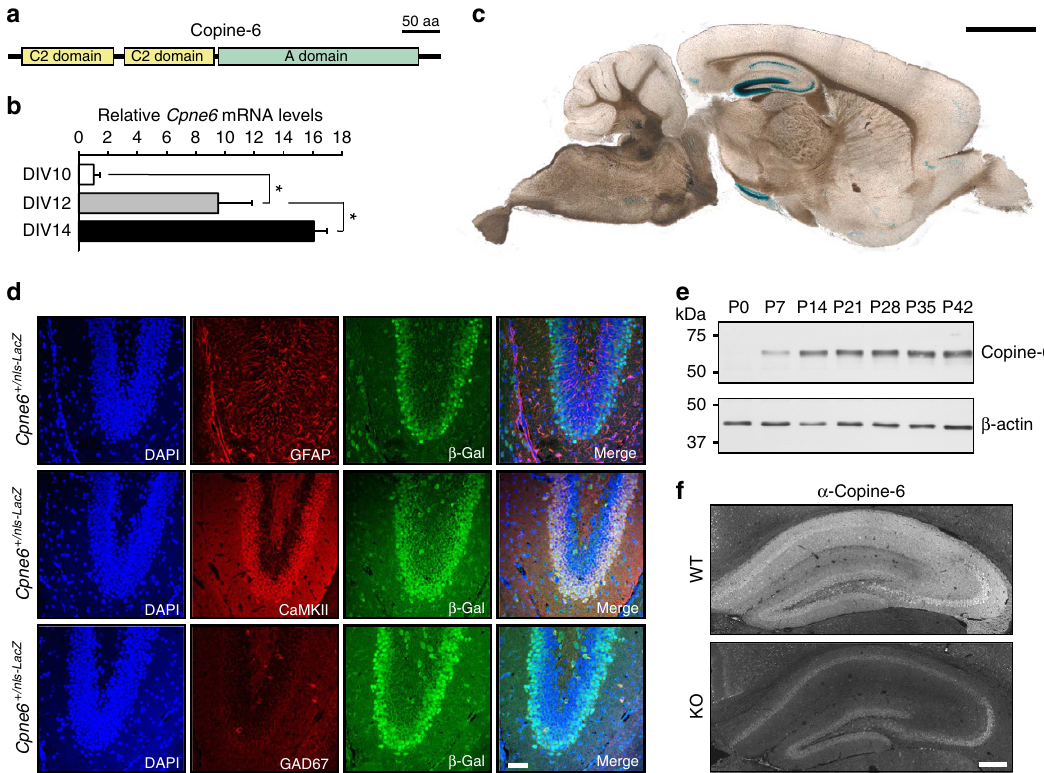
Figure 1 | Expression of Copine-6 in cultured hippocampal neurons and postnatal brain. ( a ) Schematic illustration of the domain architecture of Copine-6. ( b ) Cpne6 mRNA levels were measured in low-density primary rat hippocampal cultures by real-time PCR at DIV 10, 12 and 14. Data are mean ± s.d. from n ¼ 2 cultures per time point. * P o 0.05 by one-way ANOVA with Tukey’s post-hoc test. ( c ) Sagittal brain section of a 6-week-old Cpne6 þ /nls-LacZ mouse. Cpne6 -driven nls-LacZ expression is detected by the blue b -Gal staining in the nuclei. Scale bar, 1.5mm. ( d ) Coronal sections of the dentate gyrus from 2-week-old Cpne6 þ /nls-LacZ mice were stained with DAPI (4,6-diamidino-2-phenylindole; blue), antibodies to b -galactosidase ( b -Gal; green) and the antigens indicated. Glial fibrillary acidic protein (GFAP; astrocyte marker); calcium/calmodulin-dependent protein kinase II (CaMKII; excitatory neurons); glutamate decarboxylase 67 (GAD67; inhibitory neurons). Scale bar, 50 m m. ( e ) Western blot analysis of hippocampal lysates of mice of indicated age. b -actin was used as loading control. ( f ) Coronal sections of the hippocampus from 6-week-old WT or Cpne6 KO mice stained with anti-Copine-6 antibodies. Scale bar, 200 m